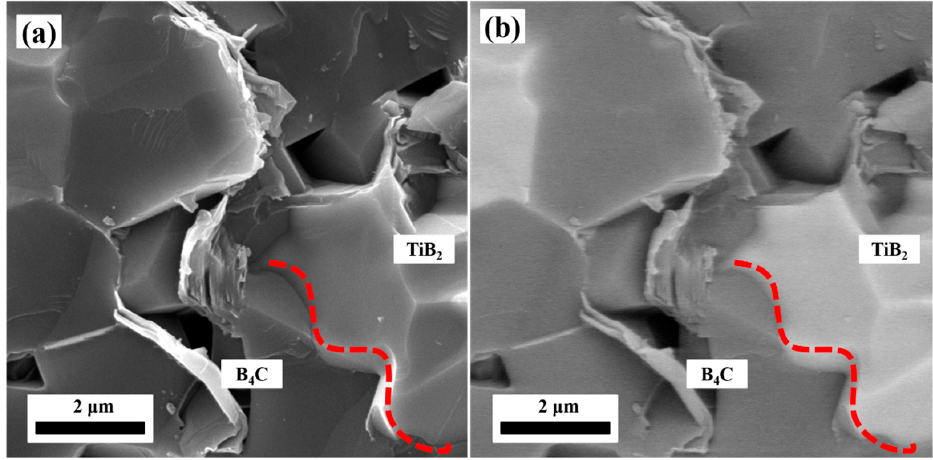
Figure 5. Interface between B 4 C and TiB 2 . ( a ) SEM image and ( b ) corresponding BSE image.